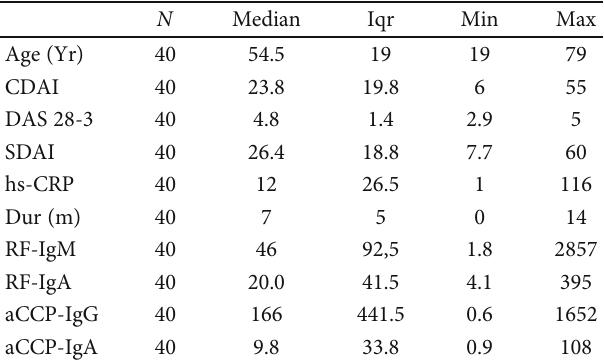
Table 1: Demographics of RA patients.